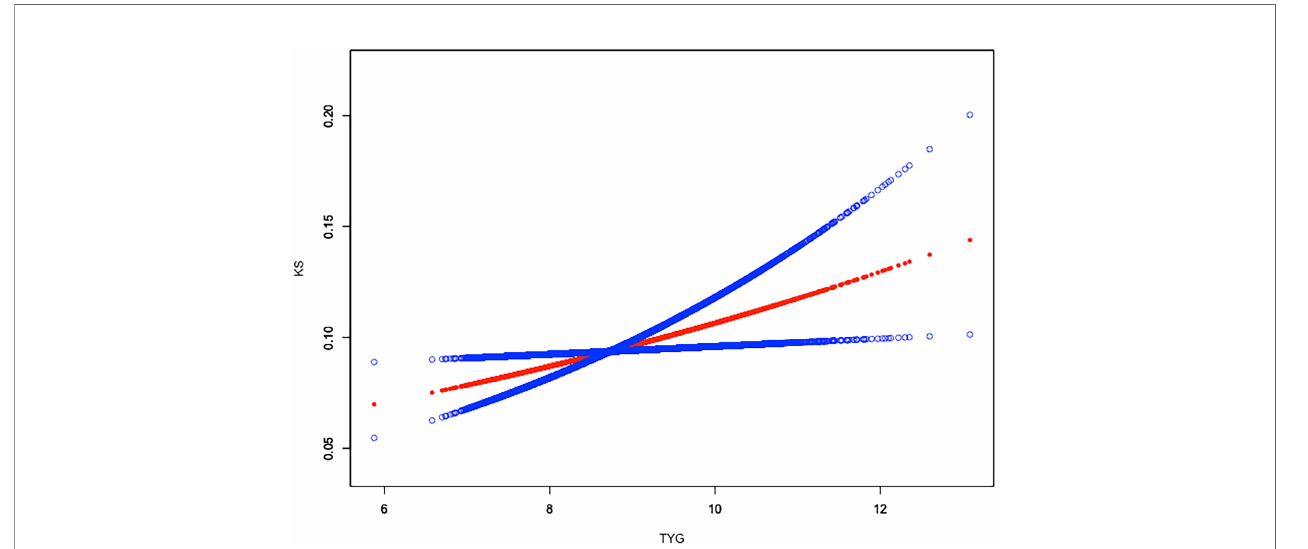
FIGURE 2 | Linear relationship between triglyceride – glucose (TyG) index and kidney stones by the generalized additive